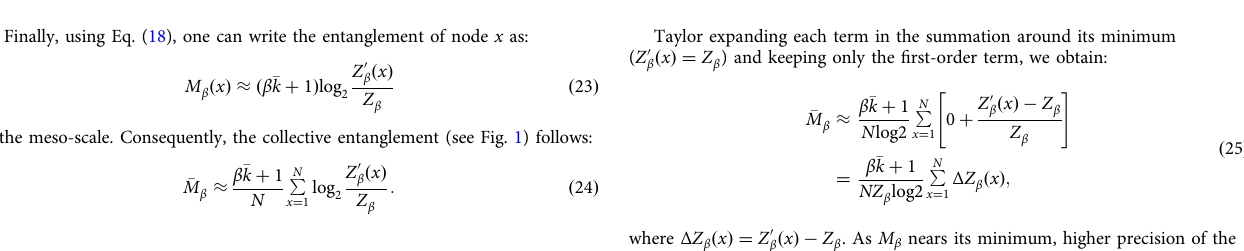
Fig. 7 Algorithmic complexity. The algorithmic complexity of entropy computations is compared, between the ( a ) exact and ( b ) approximated entropy. Red dots indicate the average computation time over fi ve realizations of Barabasi – Albert networks of different number of nodes, with attachment parameter m = 3. Note that the error bars, de fi ned as standard deviation, corresponding to the exact entropy plot are negligible. The dashed lines show the regression with polynomials of orders 1, 2, and 3. Below, four panels show the high Spearman correlation between the ranking provided by exact and approximated versions of the entanglement for ( c ) Barabasi – Albert, ( d ) Erdos – Renyi, ( e ) Stochastic block model, and ( f ) Watts – Strogatz networks. Each plot shows one realization of one of the members of the synthetic network ensemble, used through this paper. In these plots, each dot corresponds to a node, where y and x axes indicate the approximated and exact entanglement of the node, respectively. The Spearman correlations of exact and approximate entanglement of nodes are reported on top of the